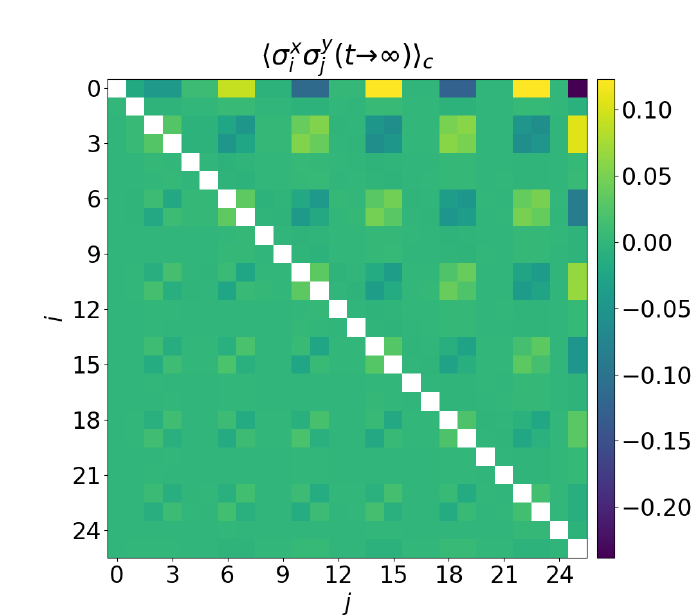
Figure 11: The X Y connected correlation matrix of all qubit pairs at the final time, in the same simulation as in Fig. 8. This two-point correlation function appears to increase (in magnitude) with the distance between the two qubits in the plaquette. The largest correlation function is between the two edge qubits – qubit 0 on the left and qubit 25 on the